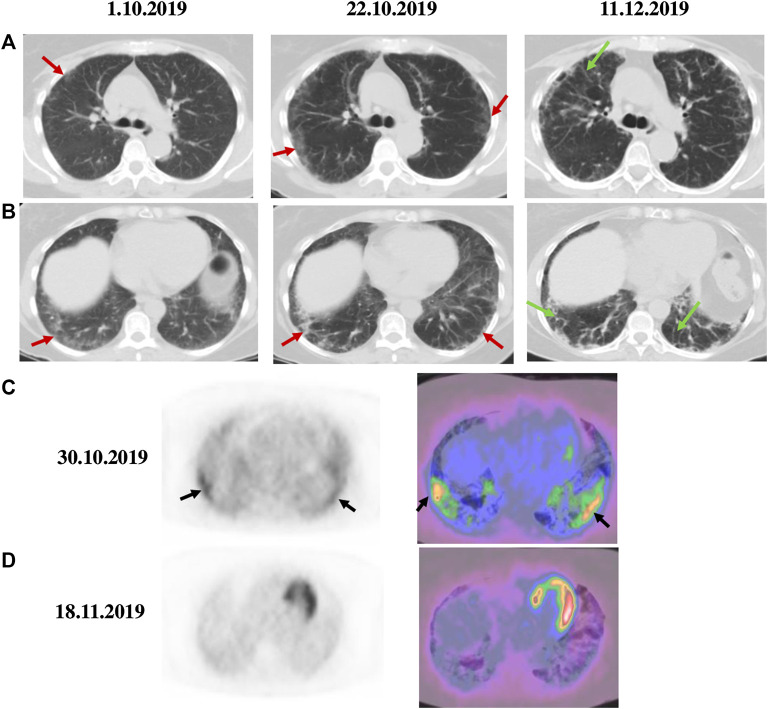
Chest CT and 18F-FDG PET/CT scans in anti-Jo-1 antibody-positive RPILD. Serial axial CT scans of upper and middle (A) as well as lower lobes of the lung (B) showed patchy ground–glass opacities (red arrows) on presentation (October 1, 2019) and worsening on hospital admission (October 22, 2019). Interlobular septal thickening (green arrows) was observed ∼6 weeks after starting therapy with tofacitinib (December 11, 2019). Axial PET (left) and fused PET/CT (right) images before (C) and after three weeks of therapy with tofacitinib (D) demonstrated a significant decrease in 18F-FDG uptake (SUV max from 4.2 to 1.9) as noted in the lower lung zones (black arrows). Tofacitinib was started on October 30, 2019 and nintedanib added on November 18, 2019.